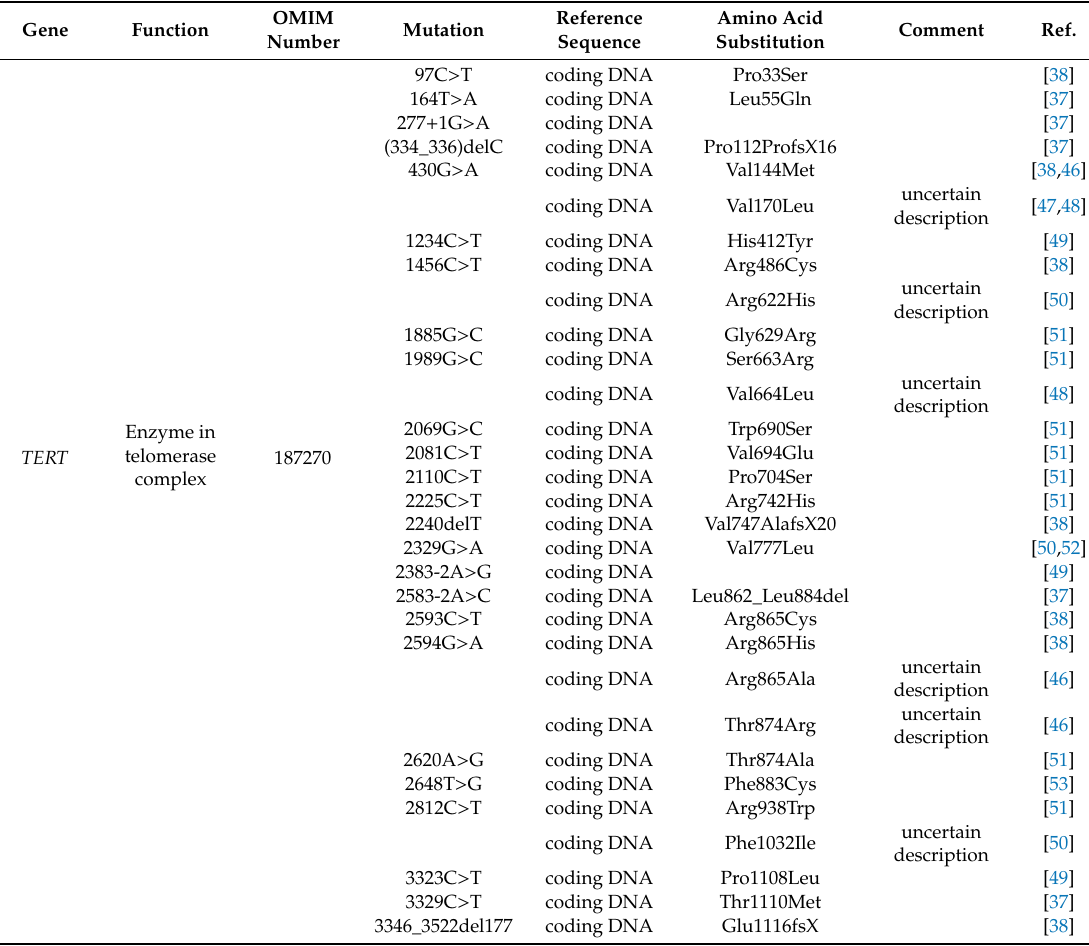
Table 1. Selected mutations linked to Idiopathic pulmonary fibrosis (IPF) and / or familial interstitial pneumonia (FIP) with